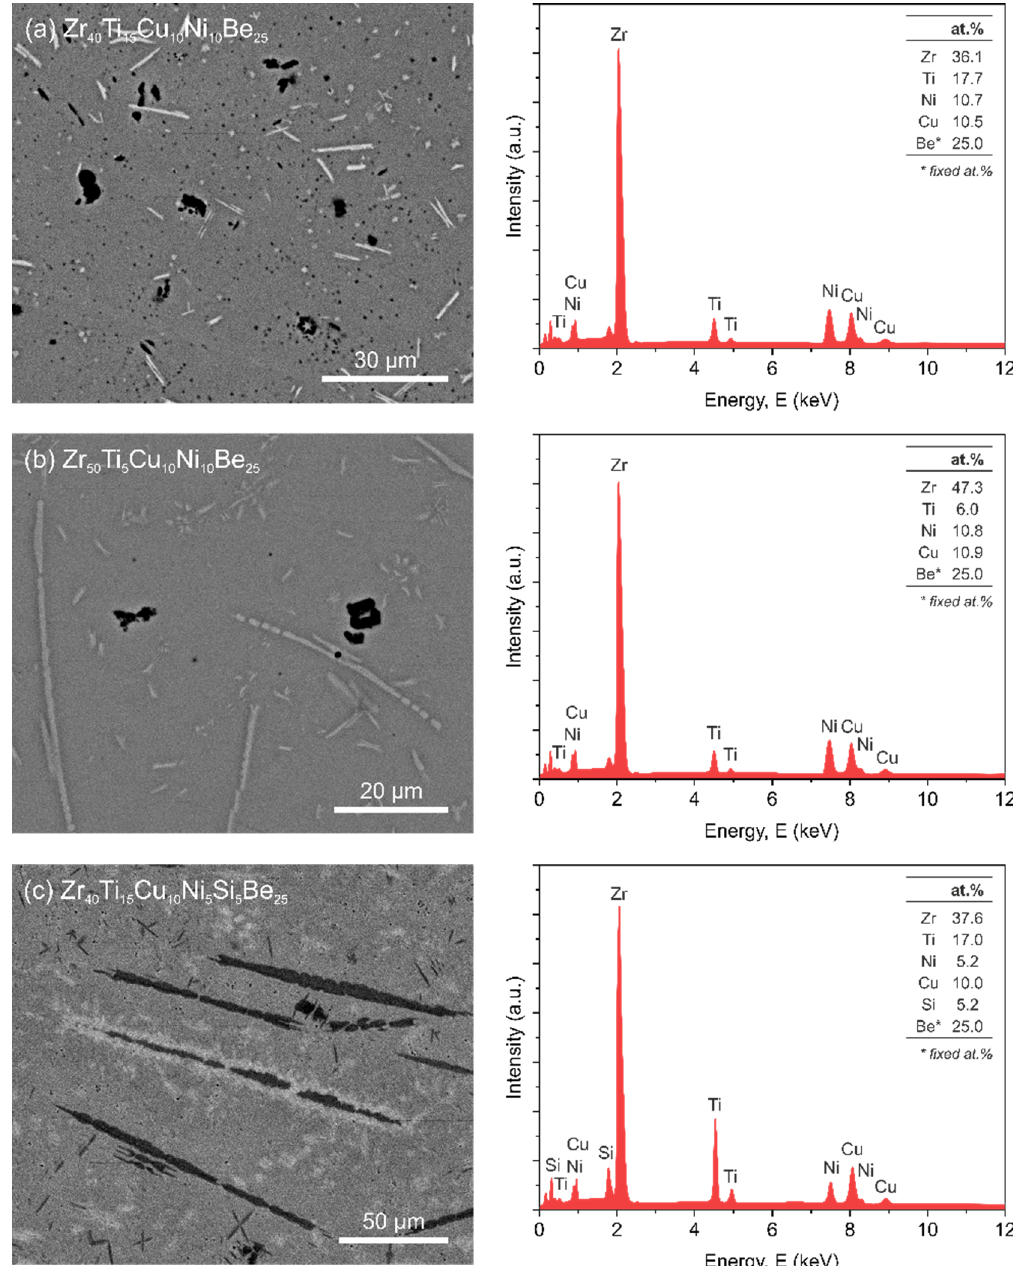
Figure 1. BSE SEM images (left column) and corresponding EDX analyses (right column) for